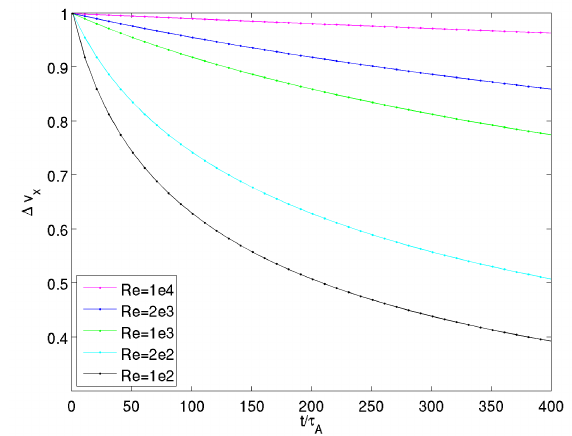
Fig. 6. Evolution of the difference in velocity ∆ V x between the central plasma (initially at rest) and the outer fast solar wind. The results are from a simple purely viscous simulation that neglects any magnetic field and resistive effect. Five viscosities are shown, from top to bottom: R v = 10 4 , R v = 2 · 10 3 , R v = 10 3 , R v = 2 · 10 2 and R v = 10 2 .